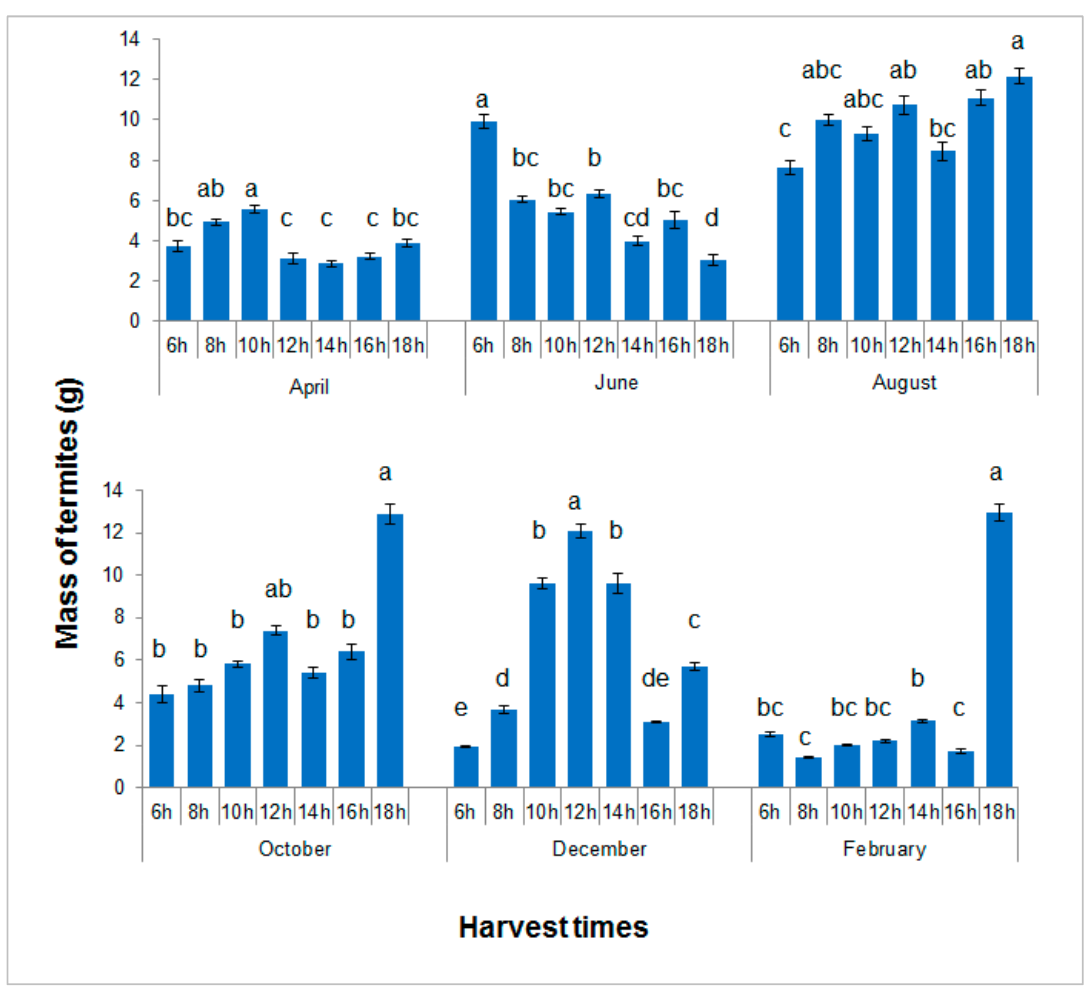
Figure 10. Average masses of termites harvested per container at different hours of the day. Histo- grams with the same letter during the same month are not significantly different at the 5% level. Error bars represent standard errors.